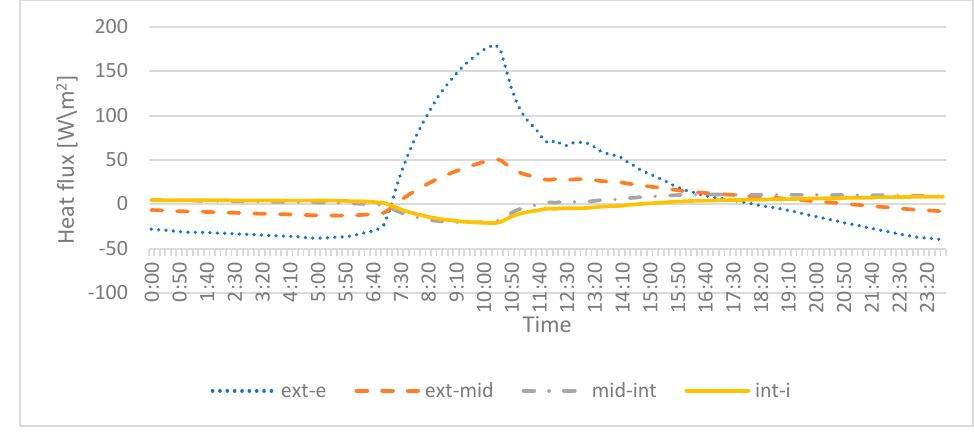
Figure 13. Fluxes of heat between the layers, the direction of the arrows indicates a positive value.